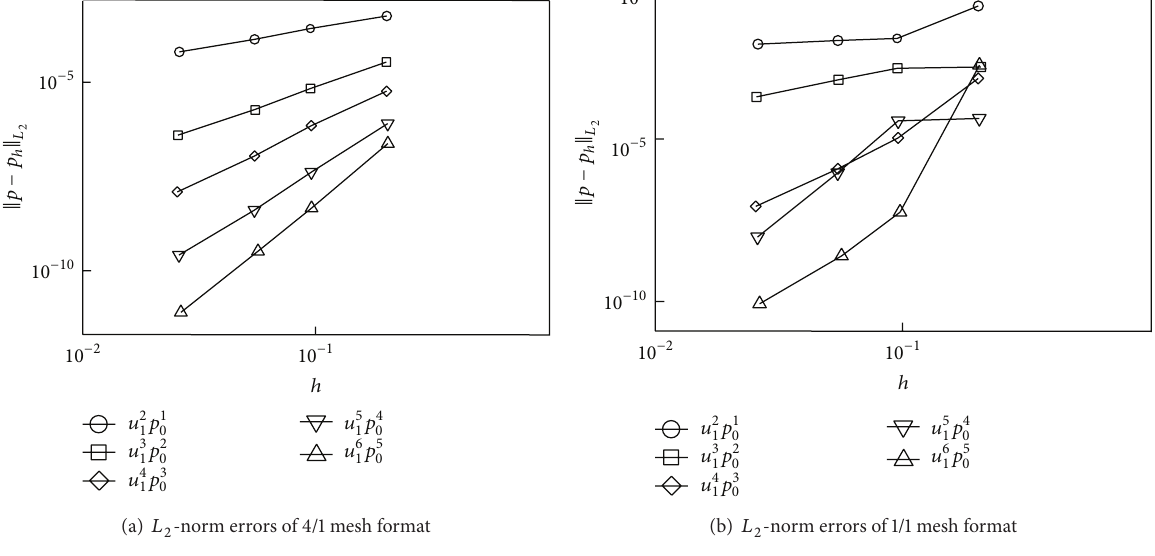
Figure 11: Convergence rate of pressure of Section 5.3.